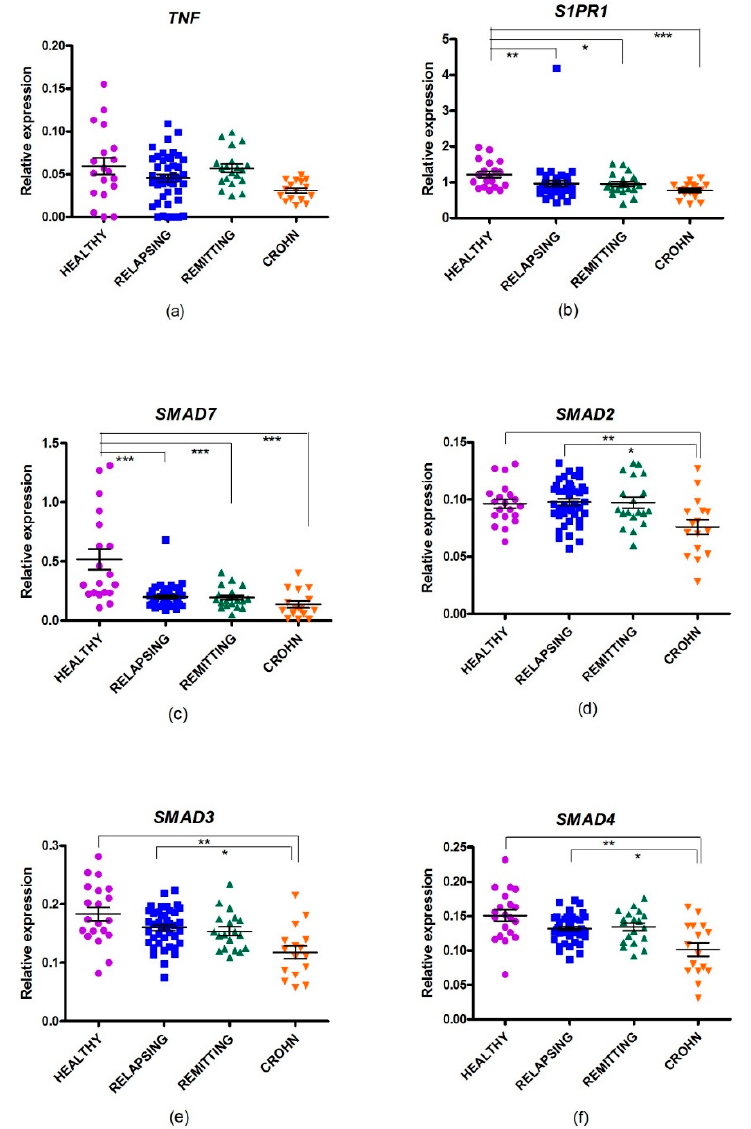
Figure 1. Relative expression of selected genes in multiple sclerosis patients in a relapsing or a remitting phase, in relapsing Crohn’s disease, and in healthy donors. ( a ) TNF ; ( b ) S1PR1 ; ( c ) SMAD7 ; ( d ) SMAD2 ; ( e ) SMAD3 ; and ( f ) SMAD4 . * p < 0.05; ** p < 0.01; *** p < 0.001.